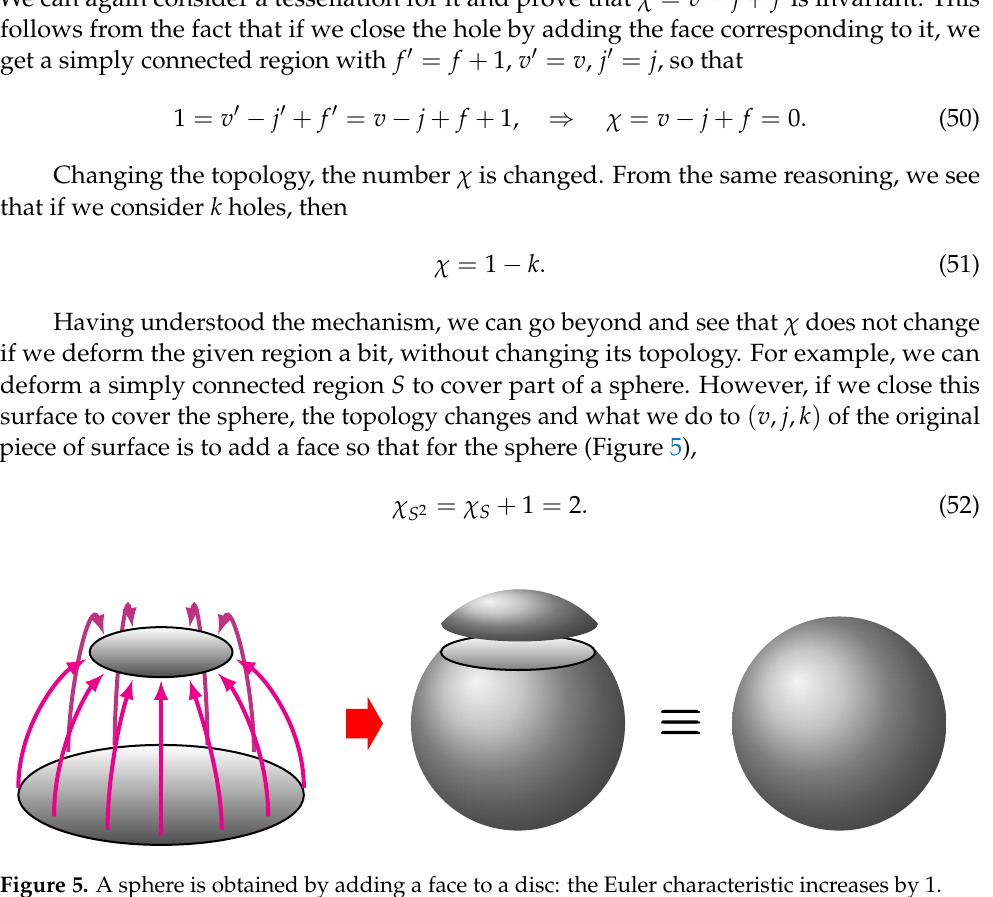
Figure 5. A sphere is obtained adding a face to a disc: the Euler characteristics increases by